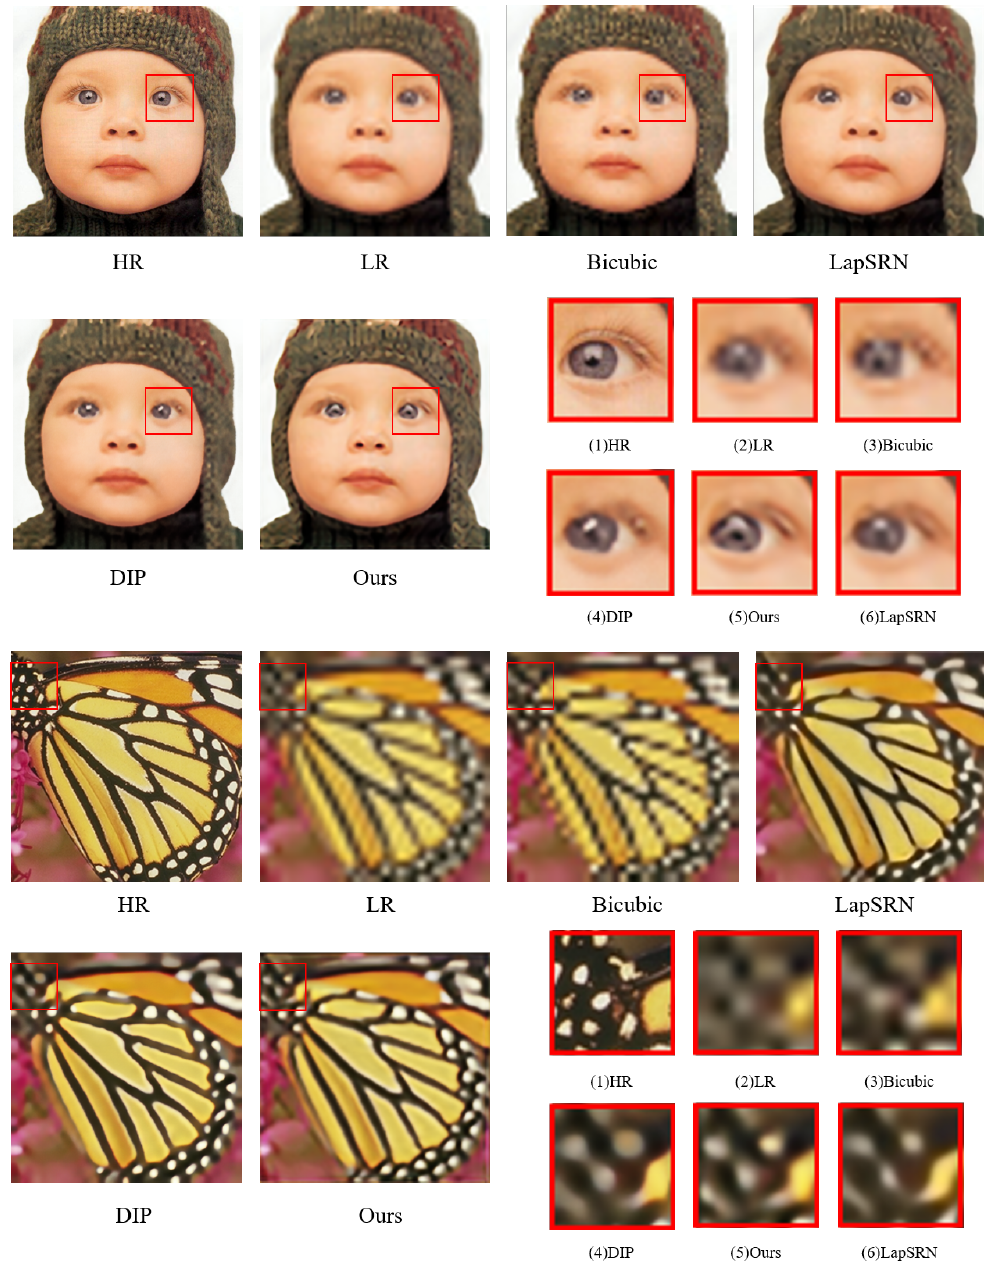
Figure 8. The visualization of 8 × super resolution